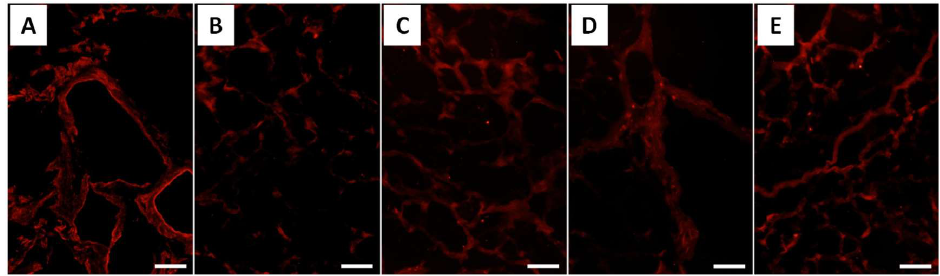
Figure 1. Histological observation (Hematoxylin and eosin staining) of native liver ( A ) and decellularized liver ( B ) (scale bars = 100 μm).